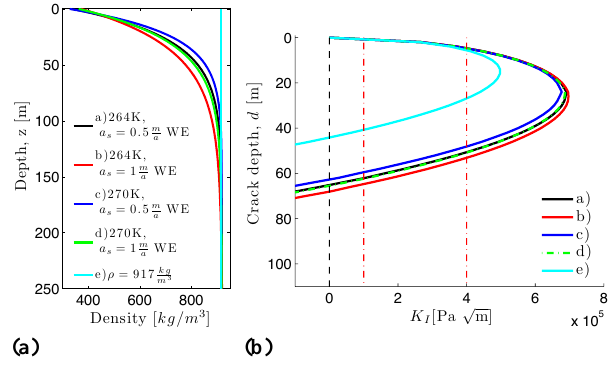
Fig. 6. (a) Applied density profiles estimated from the densification model of Herron and Langway (1980) and an additional constant profile with ρ = 917 kg m − 3 . (b) Stress intensity factors resulting from different density